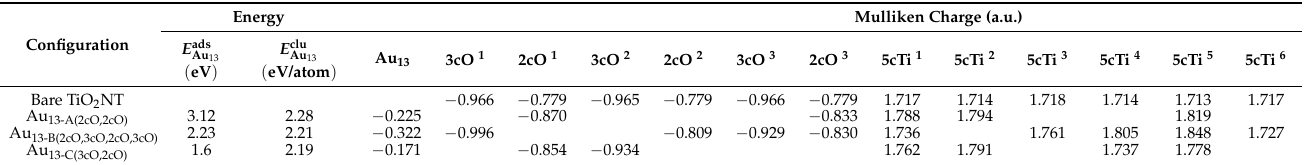
Figure 9. Four adsorption geometries for Au 13 clusters on the TiO 2 NT (6,0) are displayed as ( A – C ). ( a , b ) depict the cross-sectional view and the side view of the Au 13 cluster absorption systems, respectively. The cross-sectional views of four adsorption geometries are shown as ( A-a , B-a , C-a ), respectively. The side vies of four adsorption geometries are shown as ( A-b , B-b , C-b ), respectively. Table 3. Adsorption and clustering energies of Au 13 and atomic Mulliken charges of Au and TiO 2 NT surface atoms for the Au 13 /TiO 2 NT system in different configurations a